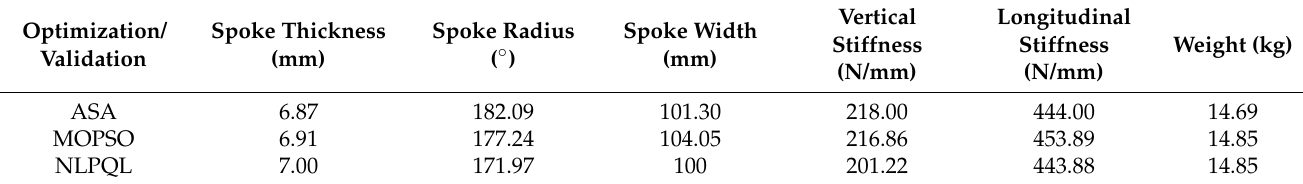
Table 6. Optimization results and FEA